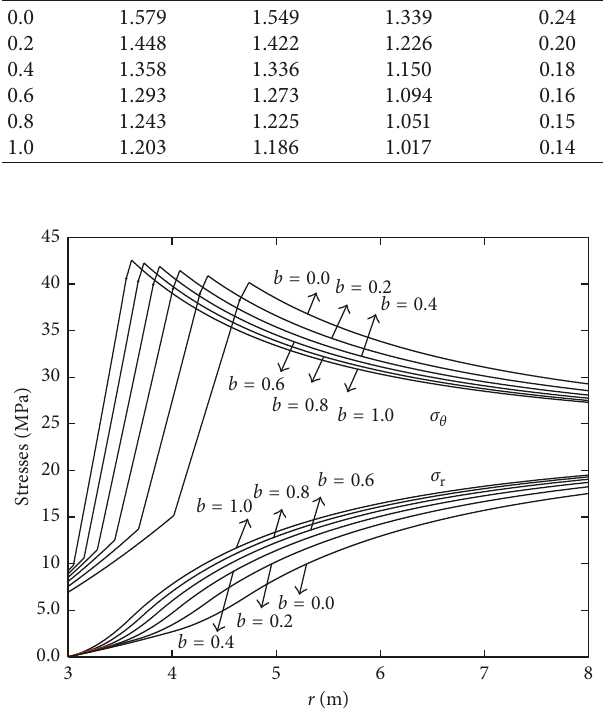
Figure 14: The influence of the parameter b on the stresses of surrounding rock.